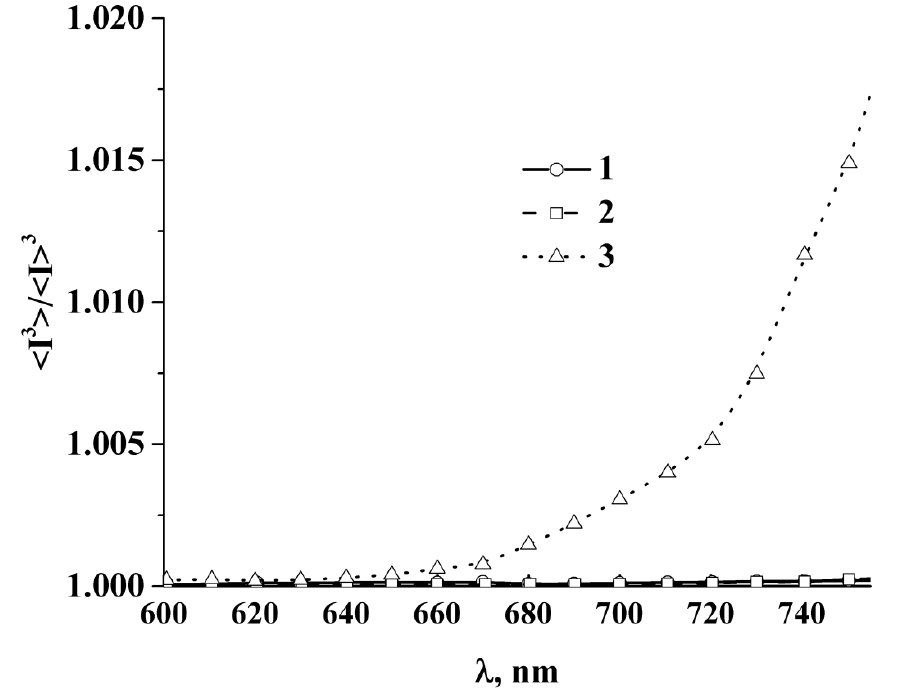
Figure 9. The same as in Figure 8 for the SiO 2 -based (b) system.